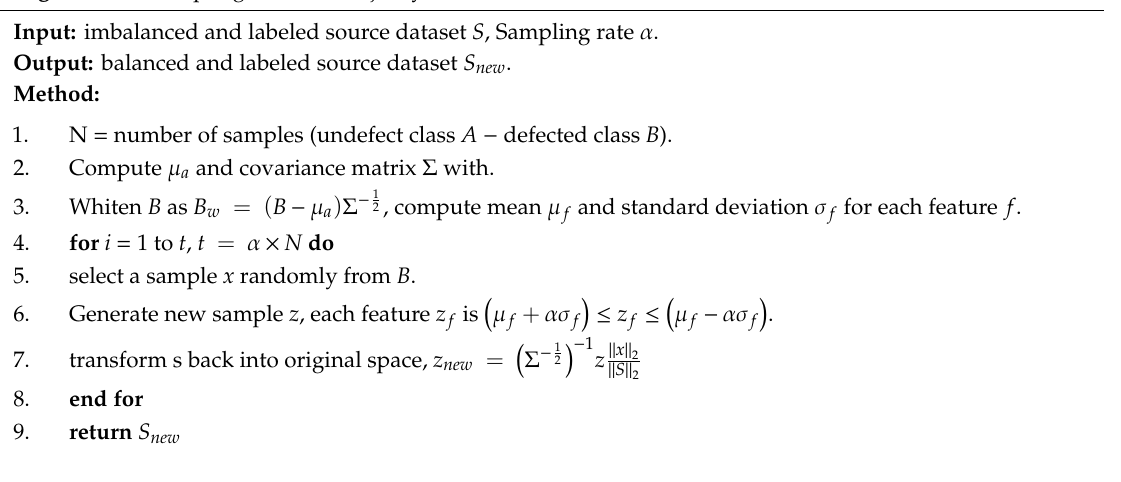
Algorithm 1. Sampling with the